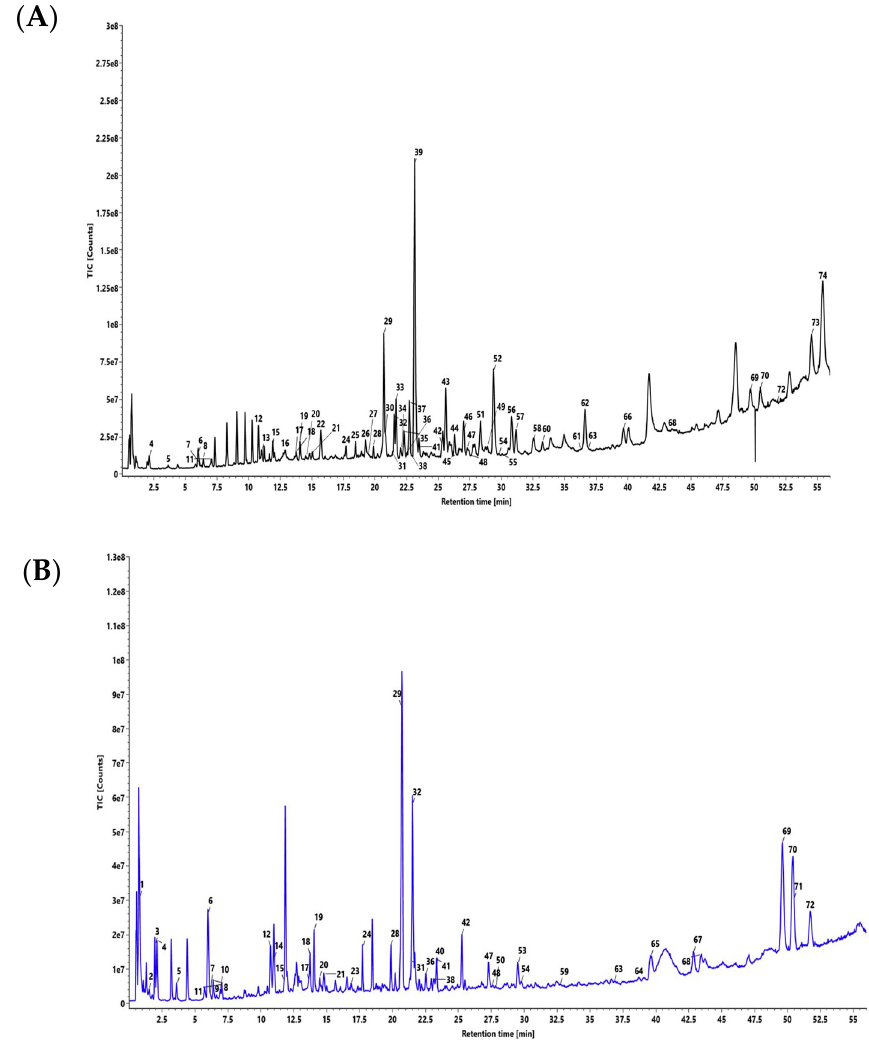
Figure 1. Total ion chromatogram of seventy-four compounds characterized in Divya-Swasari-Vati (DSV) in ( A ) positive mode and ( B ) negative mode using UPLC/QToF MS. The seventy-four compounds are , (1) quinic acid, (2) galloyl glucose, (3) gallic acid, (4) Theogallin, (5) protocaechuic acid, (6) methyl gallate, (7) 3, 4-di-O-galloylquinic acid, (8) chlorogenic acid, (9) 1,6-di-O-galloyl-glucose, (10) digallic acid, (11) cryptochlorogenic acid, (12) neoliquiritrin, (13) liquiritigenin, (14) ellagic acid, (15) quercetin-3-O- β - D -glucuronide, (16) coumarin, (17) kushenol O, (18) licurazide, (19) liquiritin apioside, (20) liquiritrin, (21) N-feruloyltyramine, (22) cinnamic acid, (23) 24-hydroxy licoricesaponin A3, (24) licoricesaponin A3 (25) glabrolide, (26) eugenol, (27) piperanine, (28) licoricesaponin G2, (29) glycyrrhizin, (30) piperyline, (31) 3-o-( β - D -glu- coronopyranosyl (1-2)- β - D -galacto pyranosyl) glycyrrhetic acid, (32) licoricesaponin K2, (33) 6-gingerol, (34) 4,5-dihy- dropiperlonguminine, (35) piperlonguminine, (36) licoricesaponin J2, (37) feruperine, (38) licoricesaponin C2, (39) piper- ine, (40) shinpterocarpin, (41) licoricesaponin B2, (42) glabridin, (43) piperettine, (44) piperolein A, (45) dipiperamide E, (46) retrofractamide A, (47) glabrol, (48) 1- methoxyphaseollidin, (49) piperolactam-C9:1 (8E), (50) 1-methoxyphaseollin, (51) dehydropipernonaline, (52) pipernonaline, (53) 2- α hydroxyursolic acid, (54) licochalcone A, (55) dipiperamide-D, (56) piperolein B, (57) pipercide, (58) 10,11-dihydropipercide, (59) sophoranodichromane D, (60) piperundecalidine, (61) shinflavanone, (62) guineesine, (63) glycyrrhetic acid, (64) ursolic acid, (65) glycyrrhetol, (66) liquidambronal, (67) betu- lonic acid, (68) oleanonic acid, (69) deoxyglabrolide, (70) glypallidifloric acid, (71) 5-hydroxyeicosatetraenoic acid, (72) ginkgolic acid, (73) N-isobutyl-(2E,4E)-octadecadienamide, (74) pipnoohine.